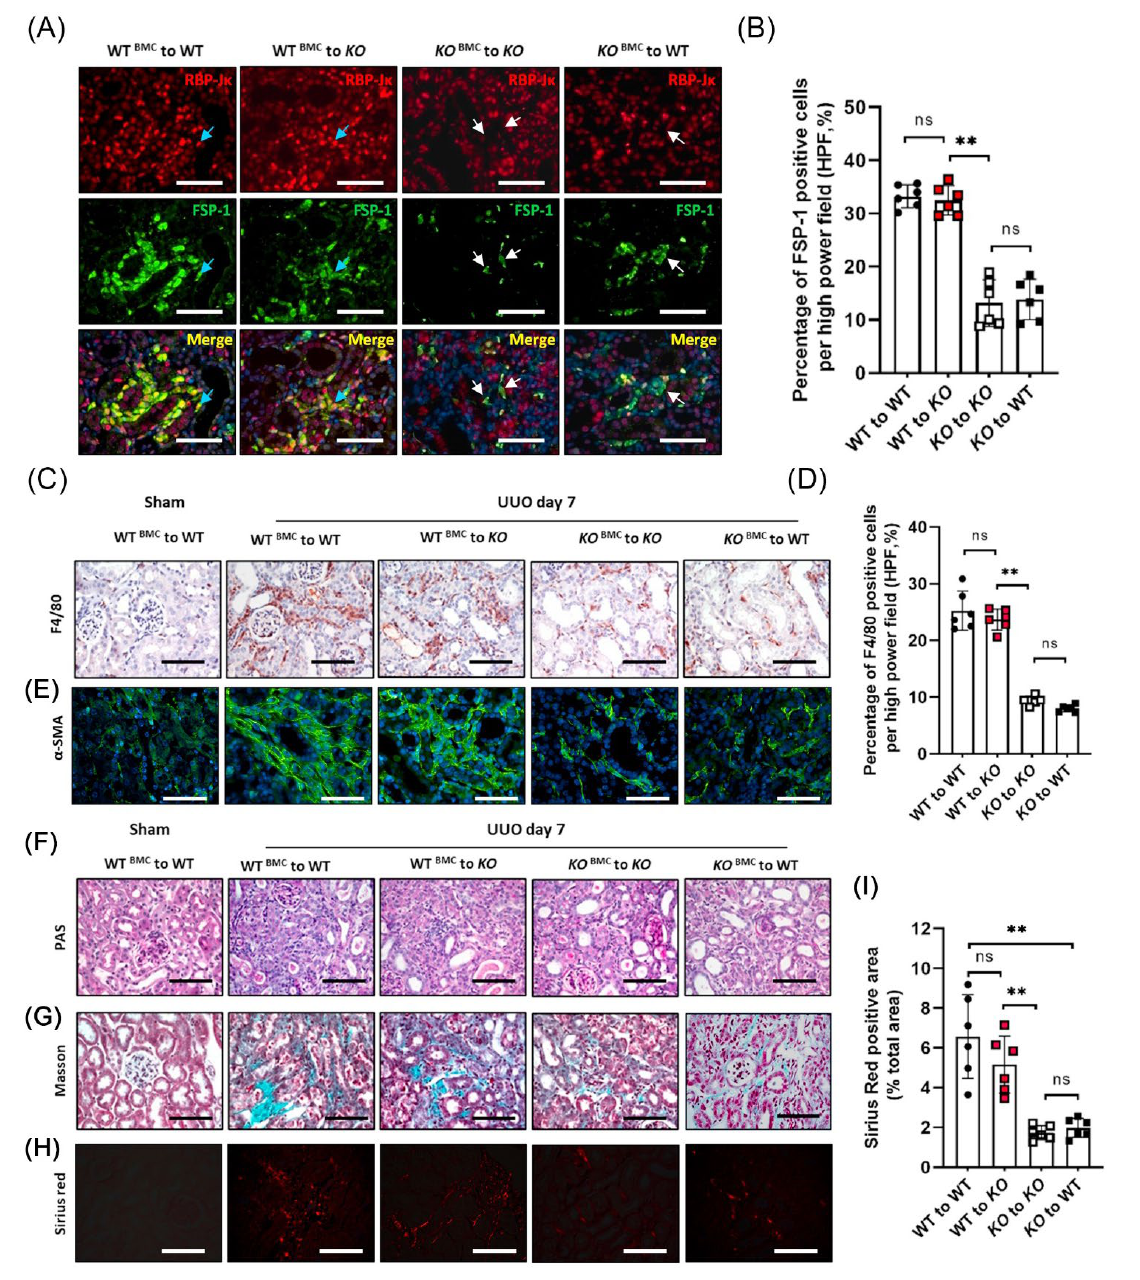
Figure 6. RBP-J κ KO in BM FSP-1 + cells suppresses UUO-induced inflammation and fibrosis. ( A , B ). Double immunofluorescent staining of FSP-1 and RBP-J κ in kidneys of BM transplanted chimeric mice after 7 days of UUO. Blue arrows point to FSP-1 + /RBP-J κ + co-staining cells; white arrows point to FSP-1 + /RBP-J κ − cells. Quantification of FSP-1 + cells of the immunostaining was shown in Panel B (**, p < 0.005). ( C – E ). Representative images of immunostaining of F4/80 and α -SMA in kidneys of BM transplanted chimeric mice after 7 days of UUO. Quantification of the immunostaining of F4/80 + cells was shown in Panel ( D ) (**, p < 0.005). ( F , G ). Histology (PAS staining) and Gomori’s Trichrome staining of kidneys of FSP-1 RBP-J κ KO BM chimeric mice after 7 days of UUO. Controlled kidneys were from WT WT BM mice. ( H , I ). Enhanced collagen deposition was determined by Sirius red staining (**, p < 0.005). The relative density analysis of Sirius red staining was shown in panel I. Bar = 50 µ m in panels ( A , C , E – H ); data are expressed as mean ± SEM, n = 6 mice. ns: no